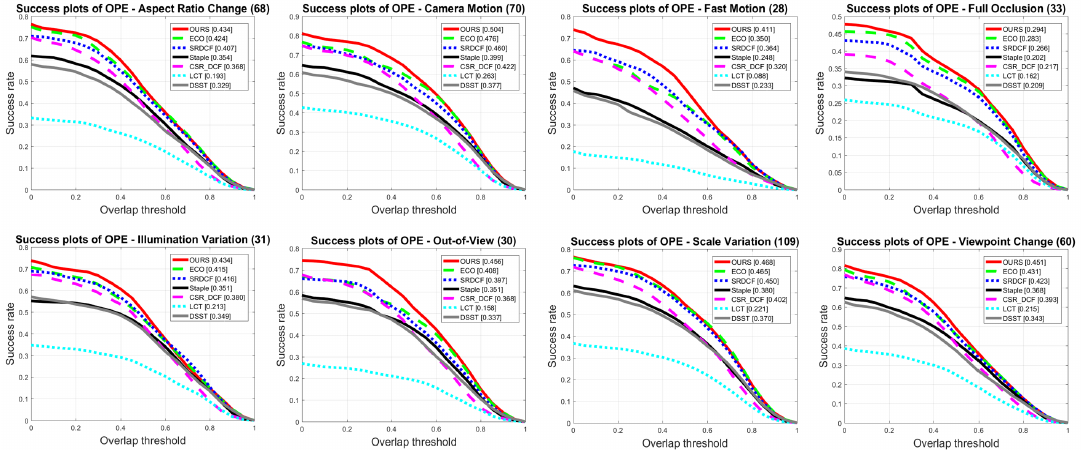
Figure 11. Success plots of trackers with 8 attributes on the UAV123 dataset.